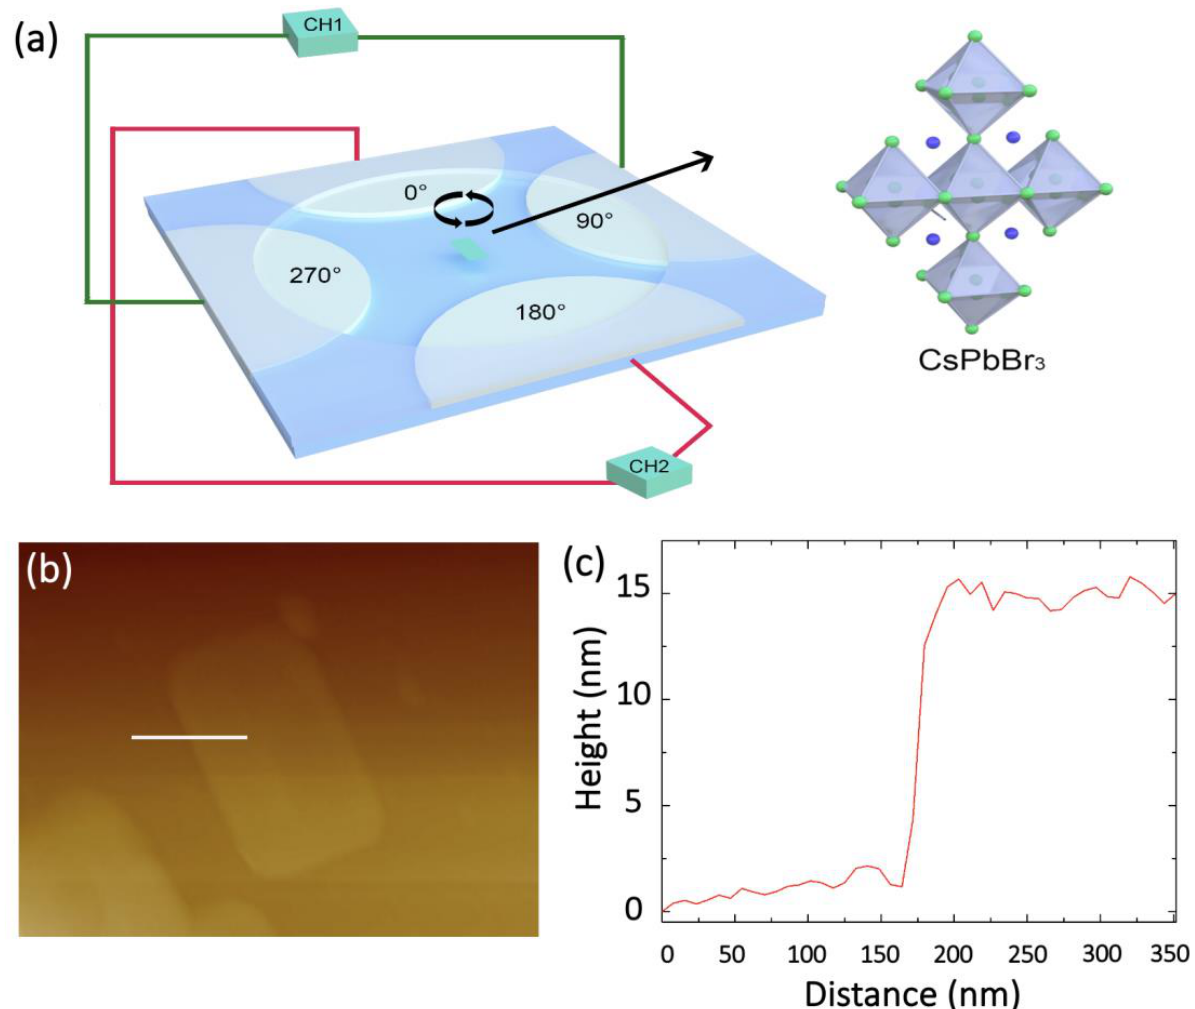
Figure 1. ( a ) Schematic illustration of the four-electrode configuration for biasing micromotor, with inset showing the crystalline structure of CsPbBr 3 . ( b ) AFM image of a typical single CsPbBr 3 nanosheet. ( c ) Cross-sectional profile of the typical single CsPbBr 3 nanosheet marked by the straight white line in ( b ).